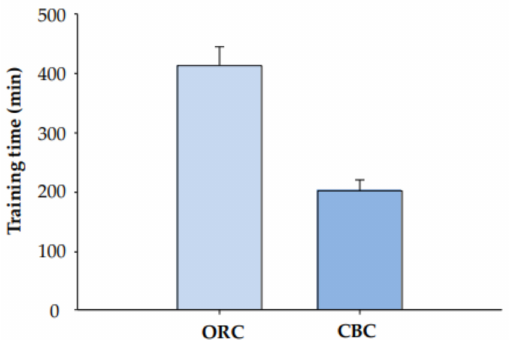
Figure 2. Amount of time (in minutes) it took to train monkeys to allow semen collection in either the ORC ( n = 15) or CBC ( n =